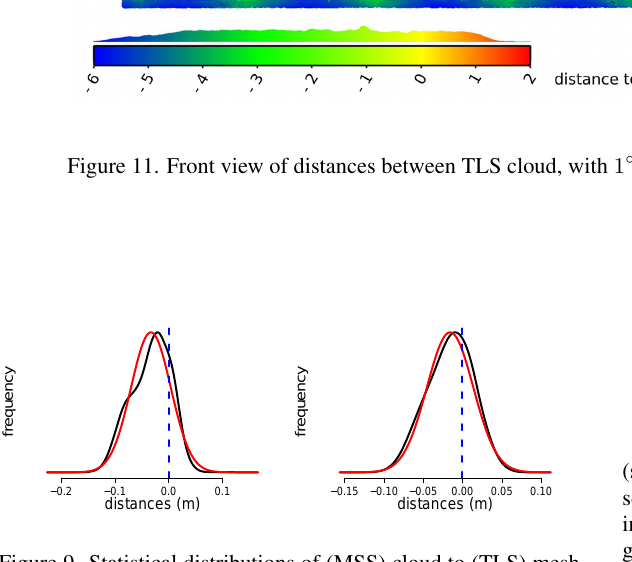
Figure 9. Statistical distributions of (MSS) cloud to (TLS) mesh distances (black curve) with Gaussian fits (red curve) for (left) left sidewall and (right) right sidewall